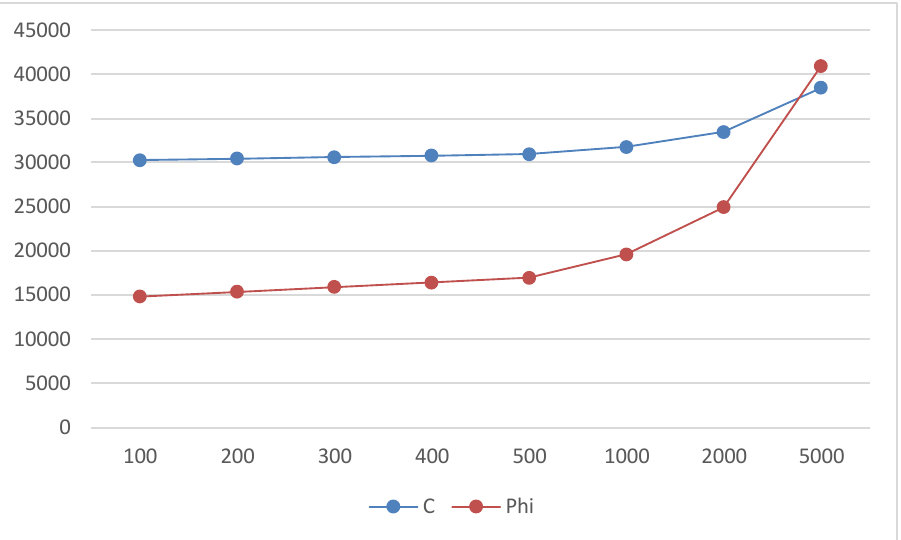
Fig. 4. Values of P under alteration of C and φ for the decentralized scenario.